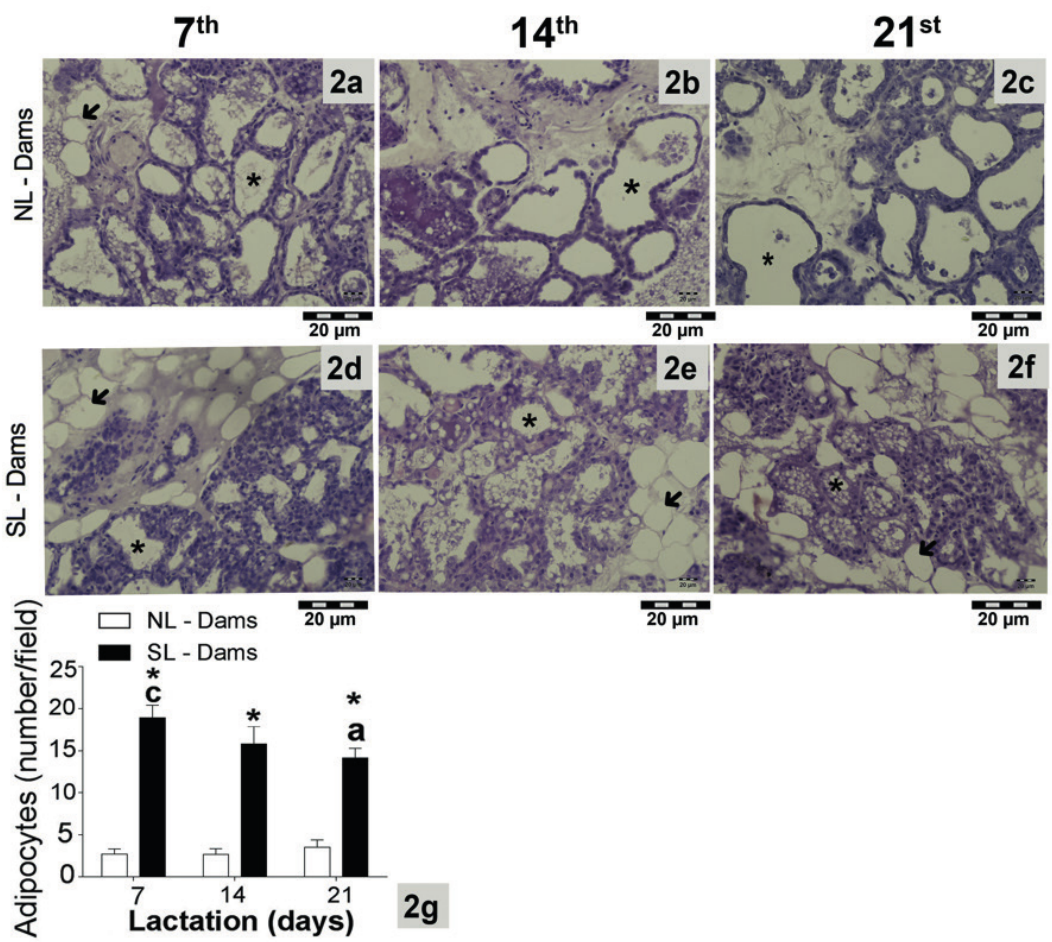
Figure 2 - Histological analysis of the mammary gland from lactating SL-dams and NL-dams during different lactational phases. The values are expressed as mean ± Standard Error of the Mean (n= 9-11 animals/group). The symbol above bars indicates a significant difference (p<0.05) between the groups (Two-way ANOVA with uncorrected Fisher´s LDS: * SL versus NL; a 7 th day of lactation and c 21 st day of